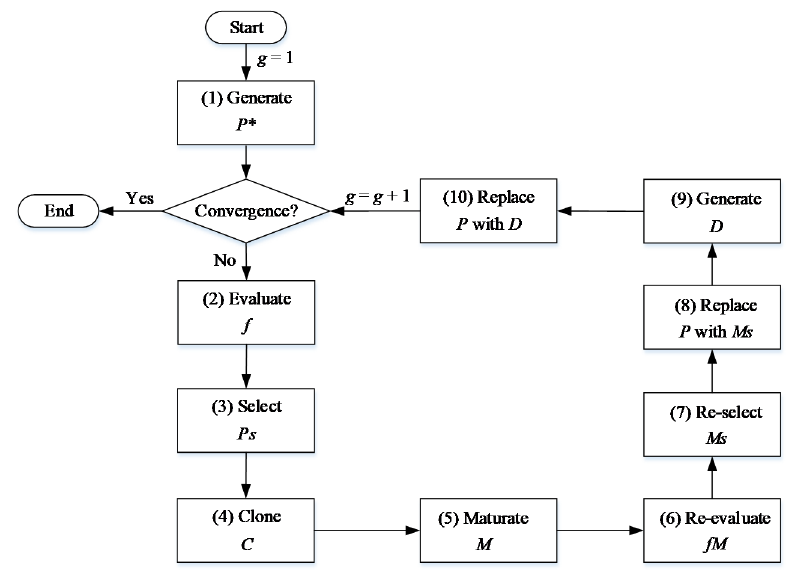
Figure 2. AIS/CLONR flowchart